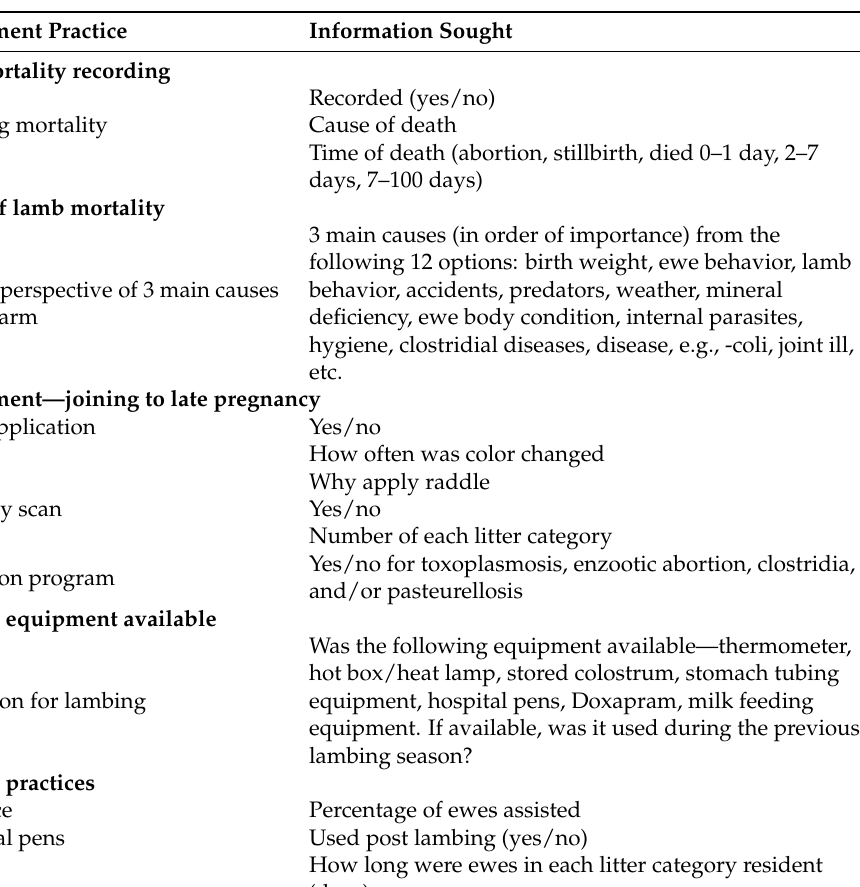
Table 1. Summary of the information sought in the